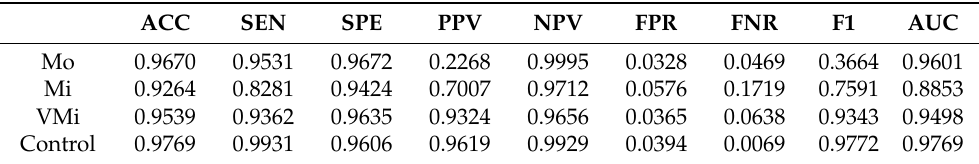
Table 4. Performance metrics of AFF-VGG19 on the dementia grading dataset. Mo stands for moderate, Mi for mild, and VMi for very mild.